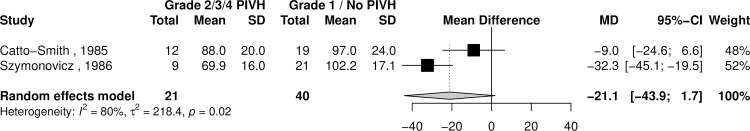
Absolute mean difference of psychomotor development index between children with no or grade 1 peri-intraventricular haemorrhage (PIVH) and children with higher degrees of PIVH.